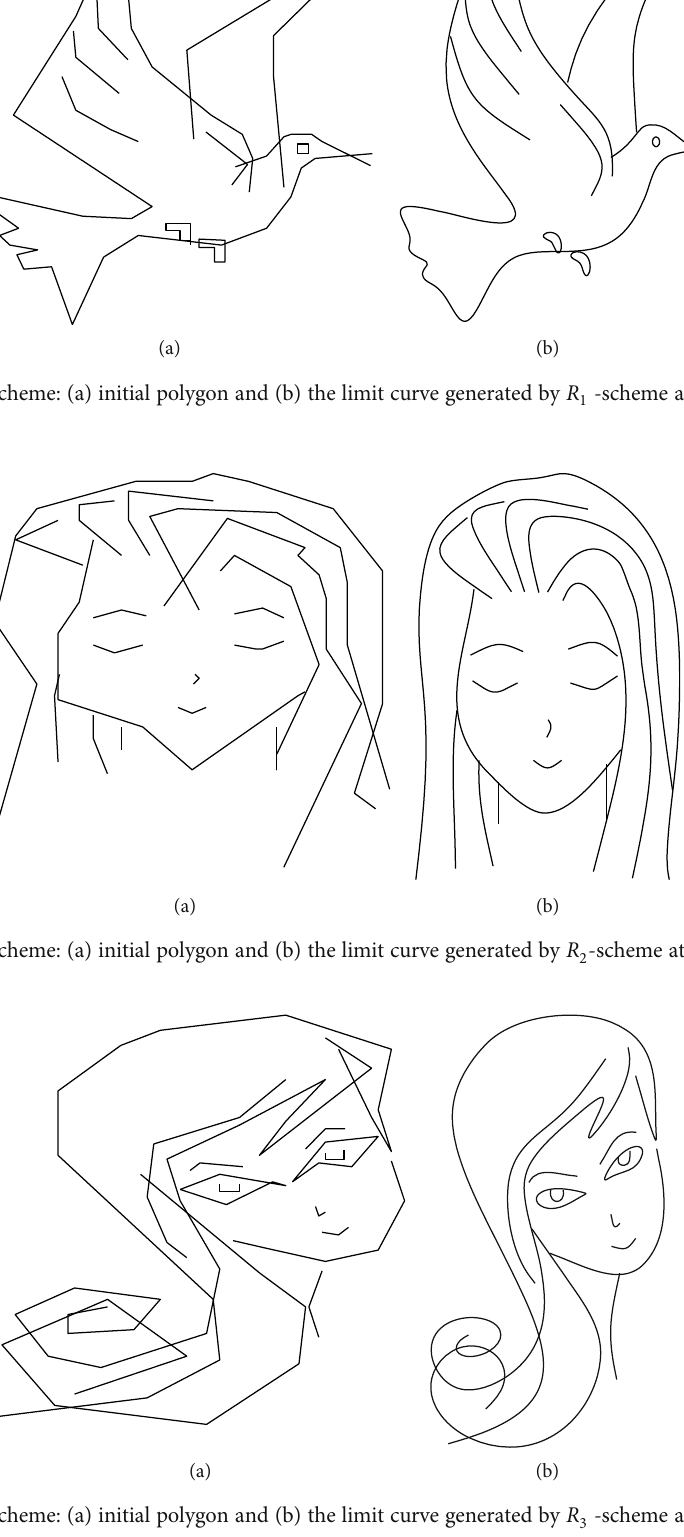
- scheme: (a) initial polygon and (b) the limit curve generated by R 3